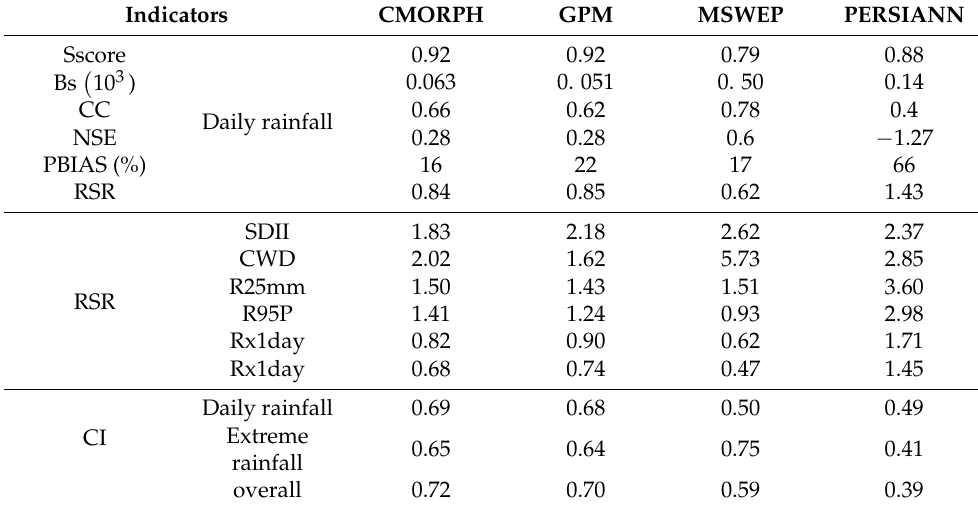
Table 2. Mean indicators value and comprehensive indicators score (CI) of the four satellite rainfall products in terms of daily precipitation and extreme